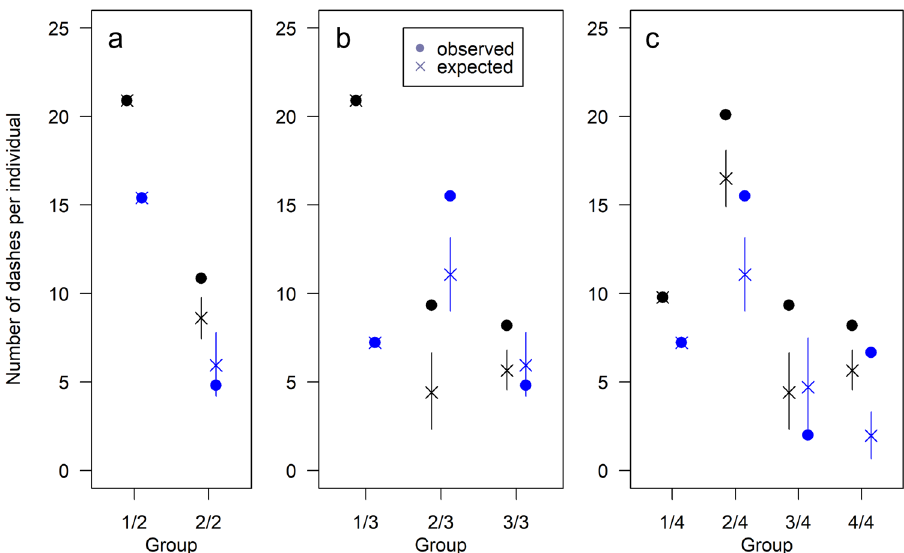
Fig. 2 Numbers of dashes per individual marlin across sub-groups. a – c Observed ( (cid:129) ) and expected (x) numbers of dashes per individual plus 2.5th and 97.5th percentile. for newly arrived groups in the period from their arrival until the arrival of the next subgroup, assuming the marlin arrived at the prey resource sequentially in a two groups, b three groups or c four groups. Individuals in newly arrived subgroups performed signi fi cantly more dashes than expected (expectation based on equal access to the prey resource for all individuals present) and thus attained greater access to the prey school than expected. Note that the perfect match between observed and expected numbers for groups 1/2, 1/3, and 1/4 is a statistical necessity as the newly arrived individuals are the only ones present. Black colours depict data for 2018 and blue for